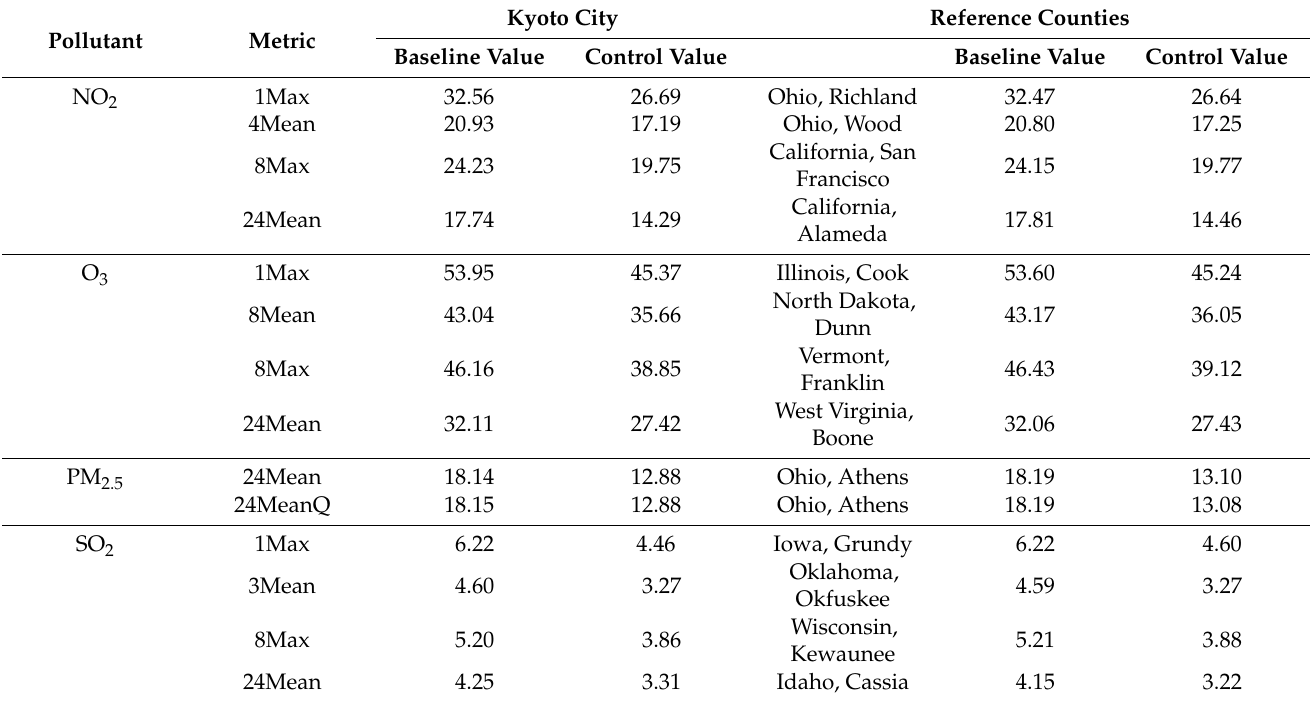
Table 4. Reference US counties for each metric and air pollutant assigned to Kyoto, Japan. Pollutant